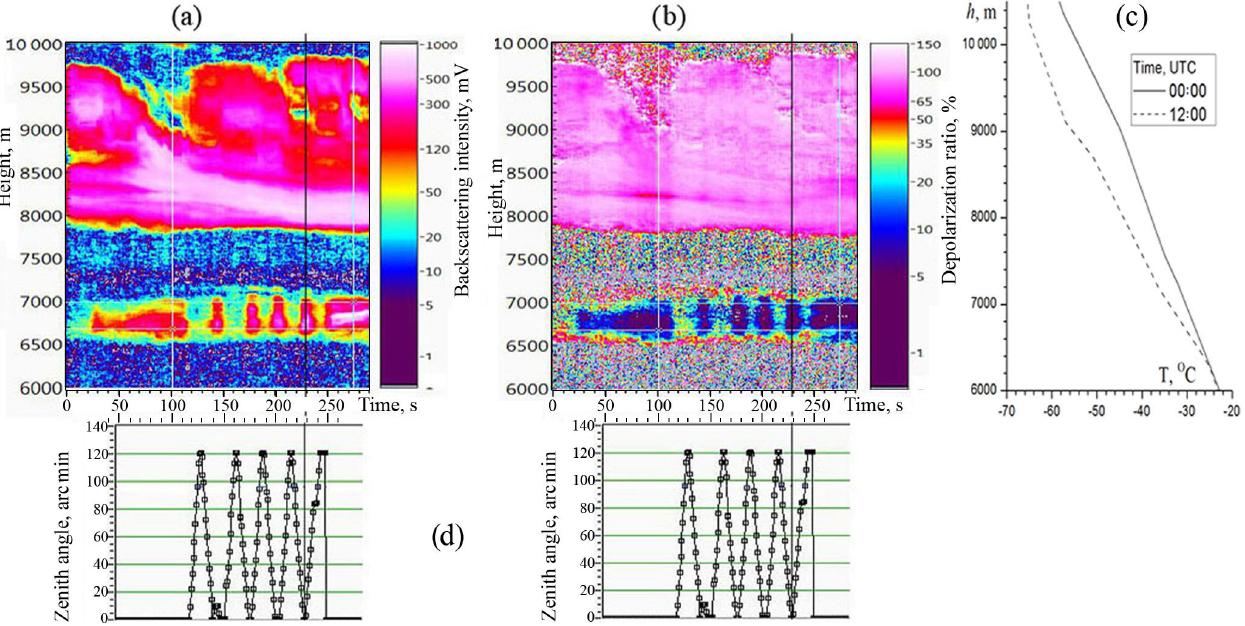
Figure 8. Lidar data on 6 April 2018 at 10:25LT (UTC + 7) for the initial circular polarization. (a) Intensity of I circ co component. (b) Depolar- ization ratio δ circ = I circ cros /I circ co . (c) Weather sounding data (Novosibirsk station at 07:00 and 19:00LT). (d) Zenith tilt angle (arcmin); time axis is aligned with (a, b) .